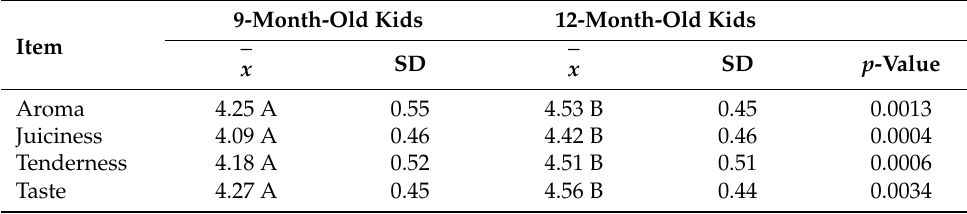
Table 5. Sensory evaluation (points) of samples of kid’s meat after